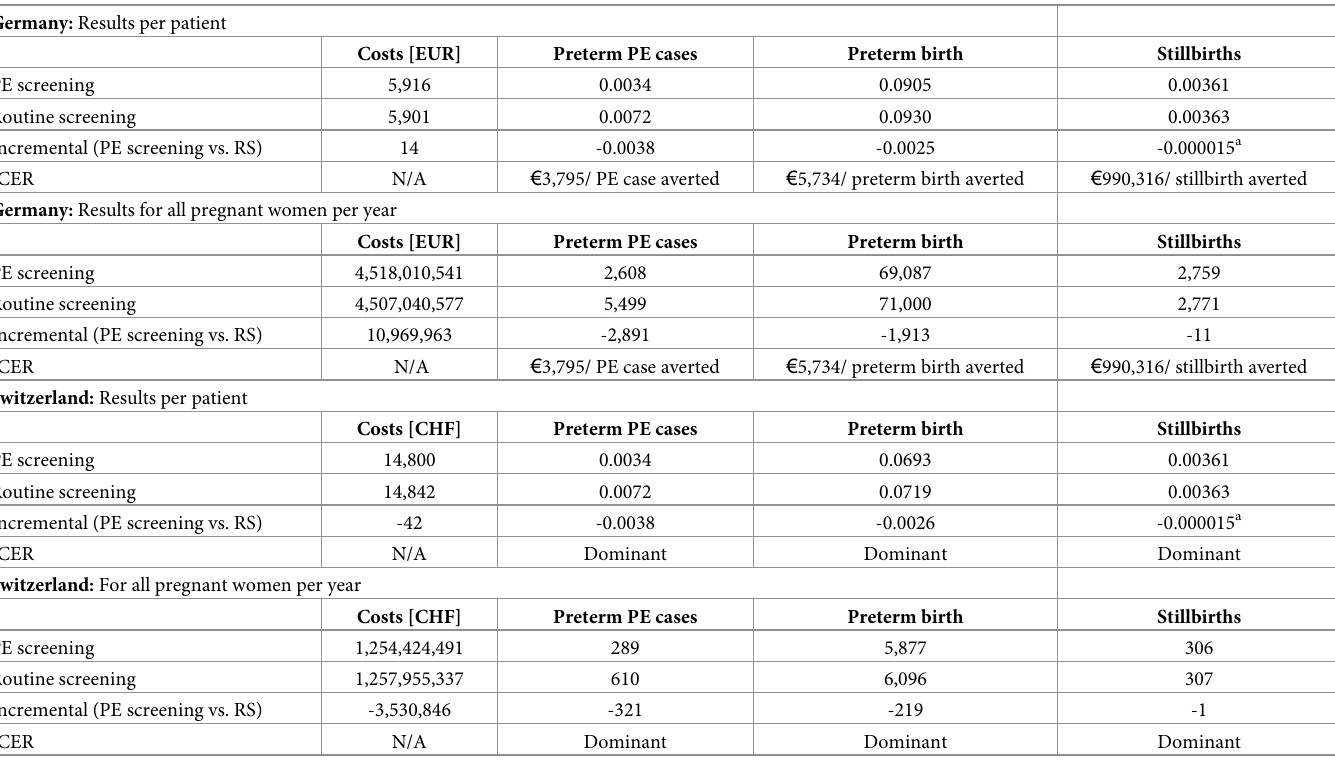
Table 3. Results for Germany and